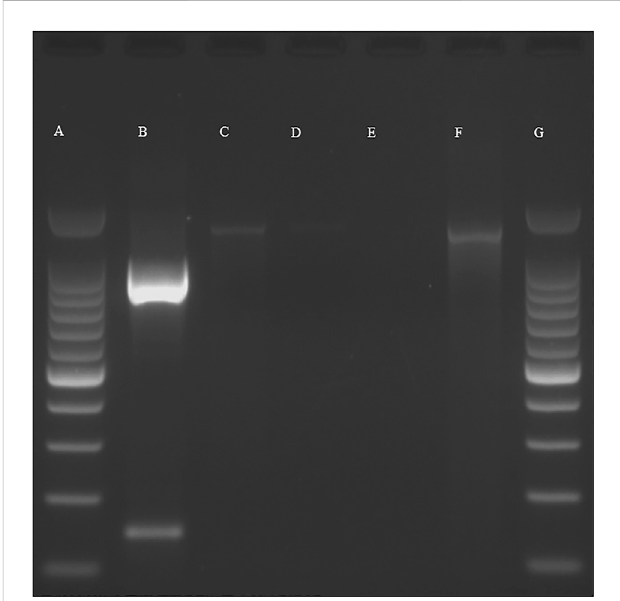
FIGURE 13 PCR with Bacillus -speci fi c primers: (A) - 100 bp ladder, (B) - 16s rRNAPCRproduct, (C) -positivecontrol( B.subtilis ), (D) -negativecontrol ( H.pylori ), (E) -negativecontrol(water), (F) -DNAisolate(singlereplicate), (G) - 100 bp ladder.